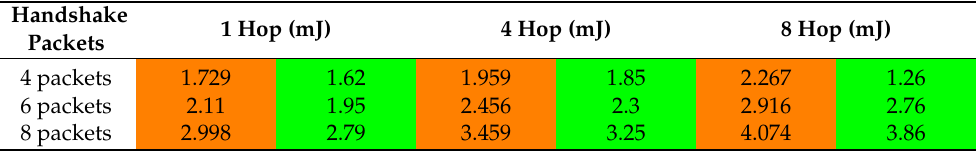
Table 13. Handshake Energy Communication Costs. Orange: results calculated from Bettoumi et al. [9] and green: LC-DEX’s